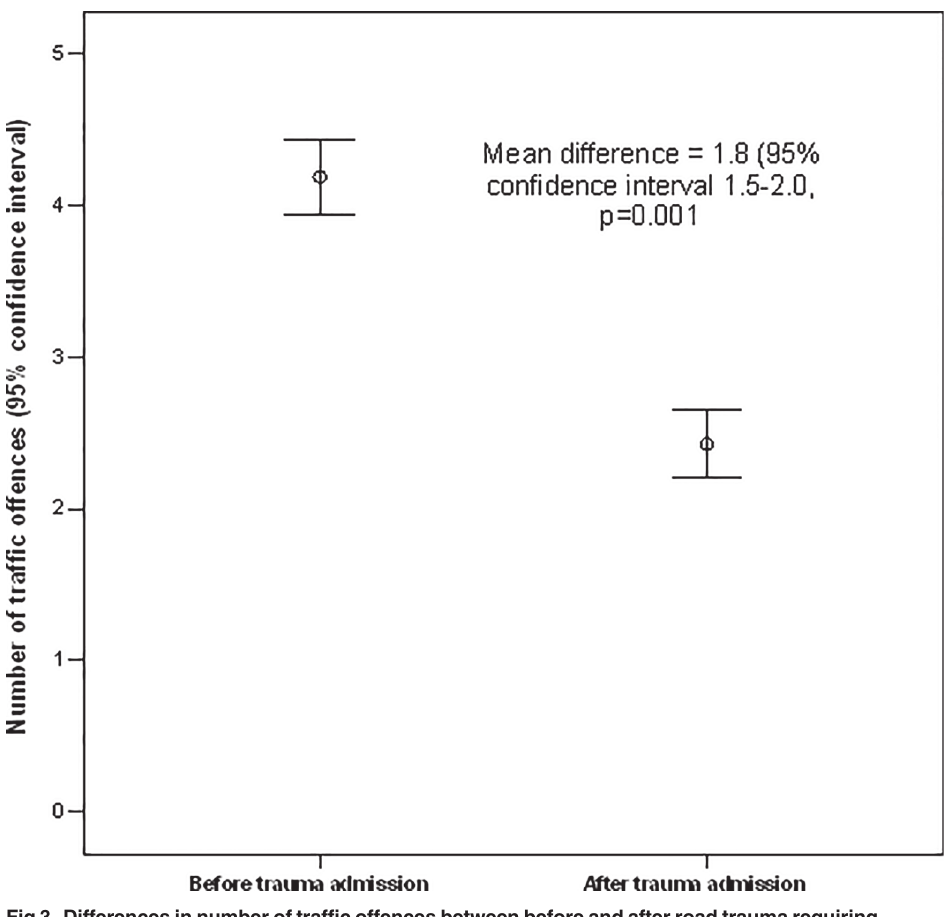
Fig 3. Differences in number of traffic offences between before and after road trauma requiring intensive care unit admission. These results remained unchanged (reduction in number of traffic offences = 1.6, 95% confidence interval 1.1 – 2.0, p = 0.001) after including only those with at least one traffic offence after their